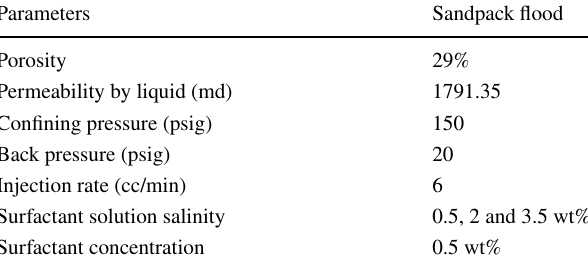
Table 4 Operating conditions of sandpack flood